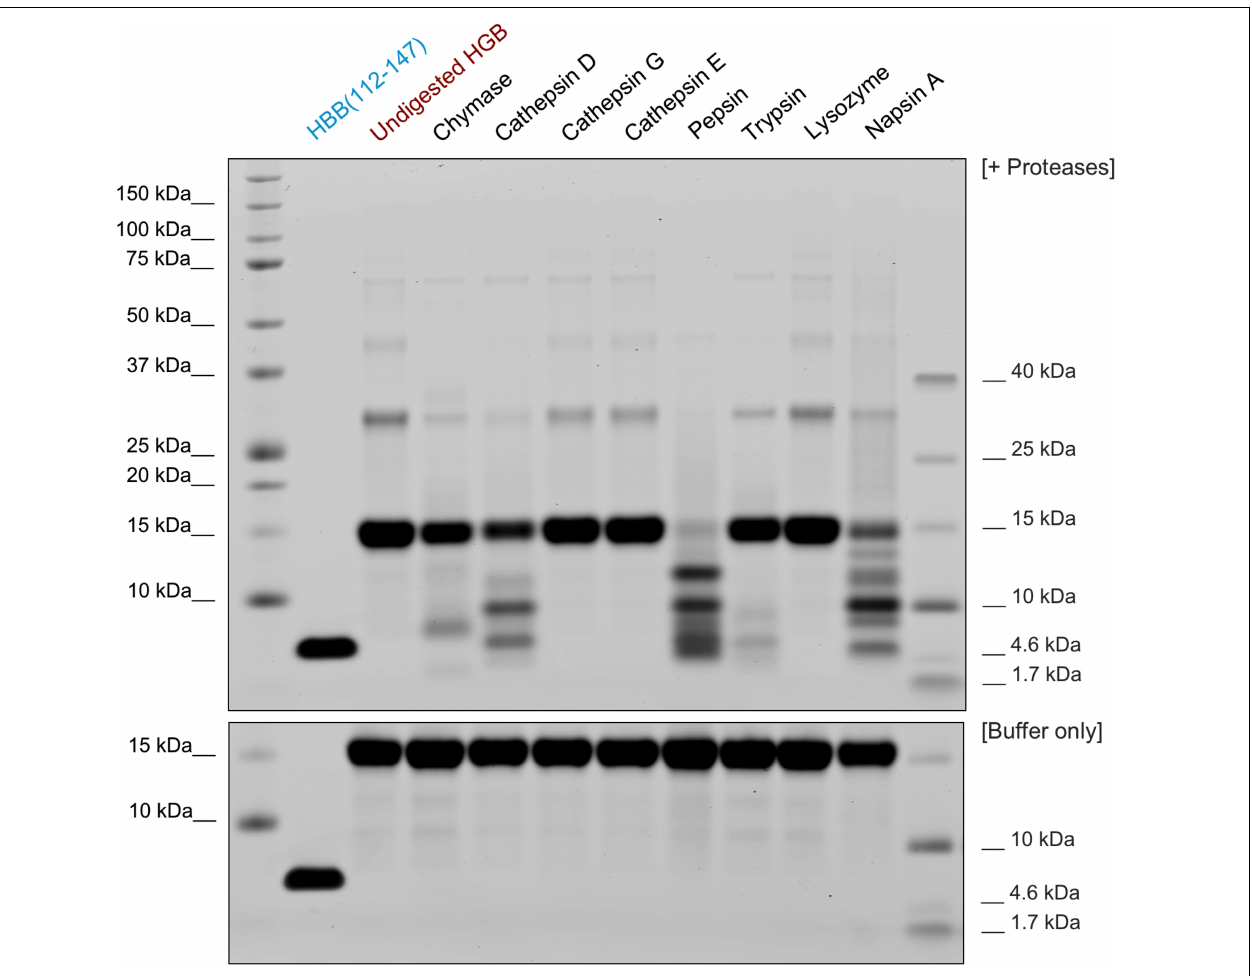
FIGURE 4 | Generation of HBB(112–147) by proteolytic digestion. Purified human hemoglobin was incubated with several proteases (at 1:100 molar ratio) and digested for 2 h at 37 ◦ C or incubated with the respective buffer only for the same time (bottom). The reactions were then separated by SDS-PAGE and total protein stained by colloidal coomassie. For the bottom panel, human hemoglobin was incubated in the respective digestion buffers without addition of protease and separated as